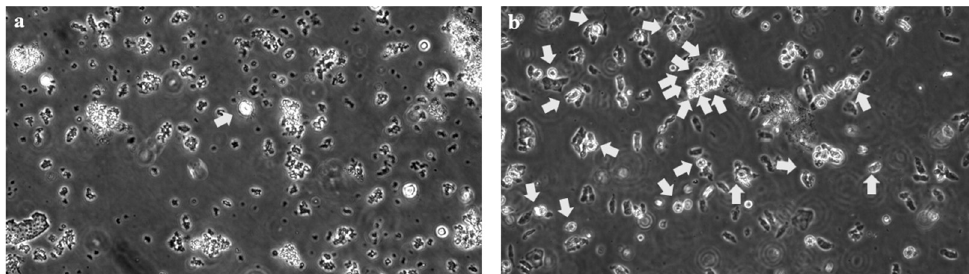
Figure 3. Captured picture ( a , b ) of videos (Video S1a,b) during the assessment of the ciliary beat. Ciliary beats for the present case ( a and Video S1a) and healthy participants ( b and Video S1b) were assessed using cells obtained by nasal mucosal brushing. Videos were recorded with a high-speed video camera (HAS-L1, DITECT). Compared with healthy participants, the velocity amplitude, angle, and coordination of ciliary beats of the patient were slower, lower, and poorer. Although only one cell in the center of the picture (white arrow) can be observed in the present movie of this case ( a and Video S1a), many cells with moving cilia were observed in healthy participants ( b and Video S1b). The original magnification of the optical microscope is 400.